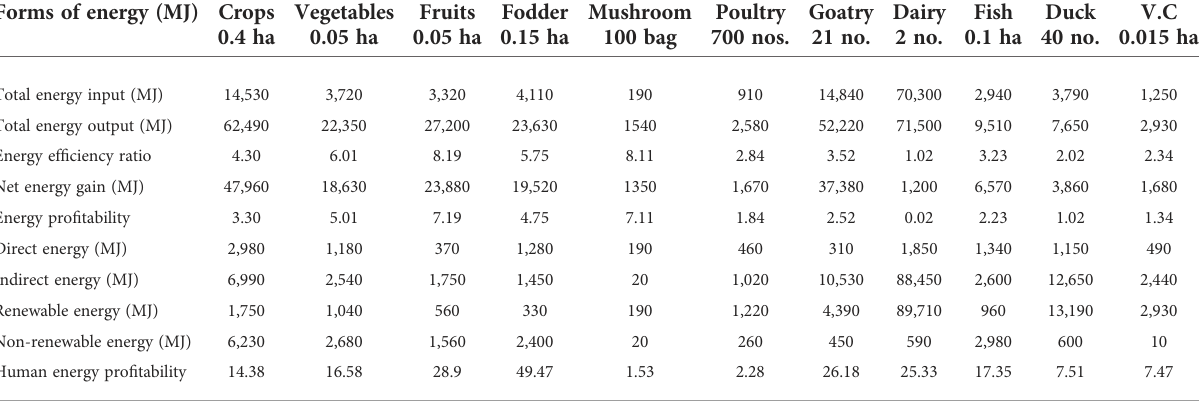
TABLE 9 Energy budgeting of individual components in developed IFS systems (pooled data of 6 years: 2016 – 2021). Forms of energy (MJ) Crops Vegetables Fruits Fodder Mushroom Poultry Goatry Dairy